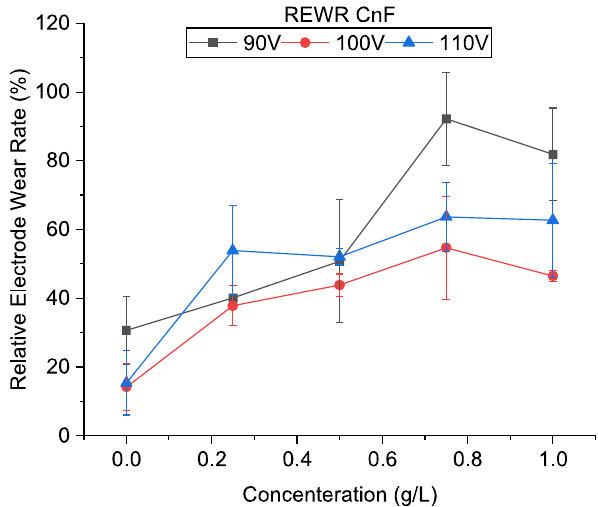
Figure 11. Relative electrode wear rate using CnF-mixed